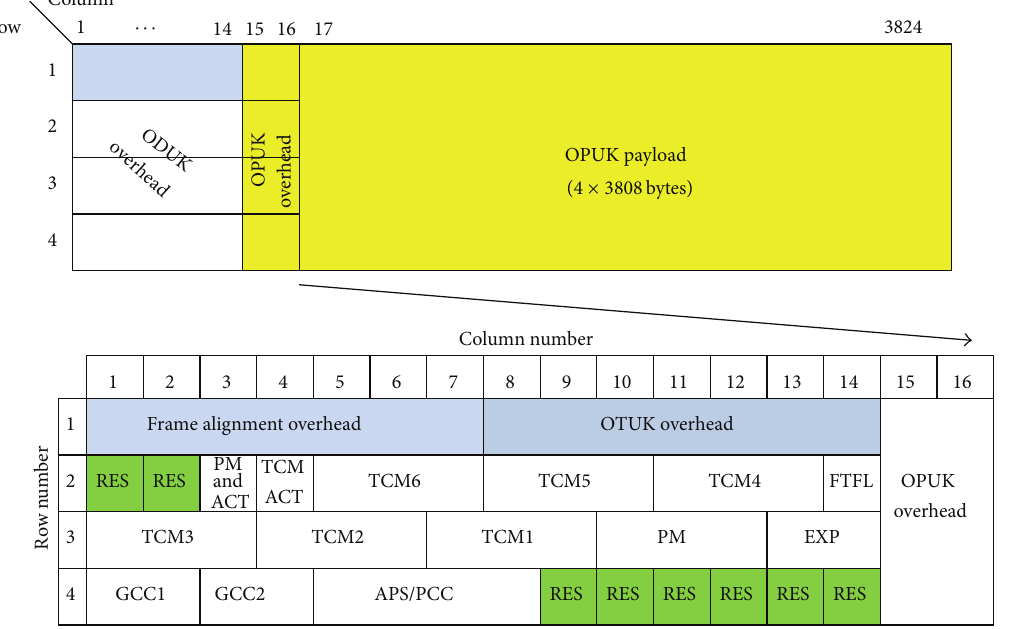
Figure 2: Optical transport network (OTN) frame format (ITU-T